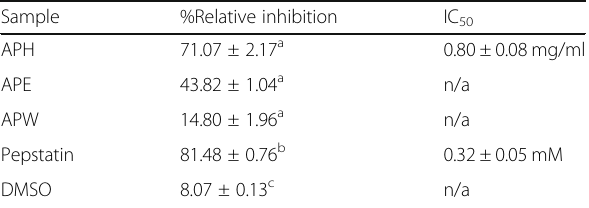
Table 1 Percentage of crude extracts Crude